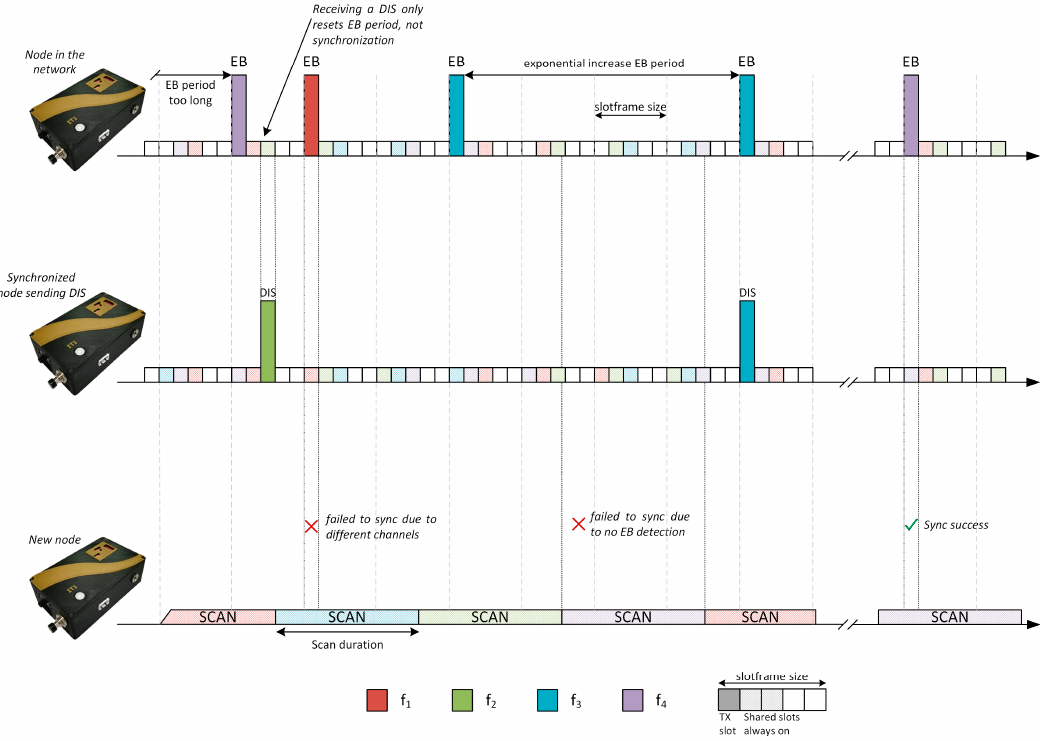
Figure 4. Enhanced Beacon transmission period triggered by RPL Trickle Timer [6].